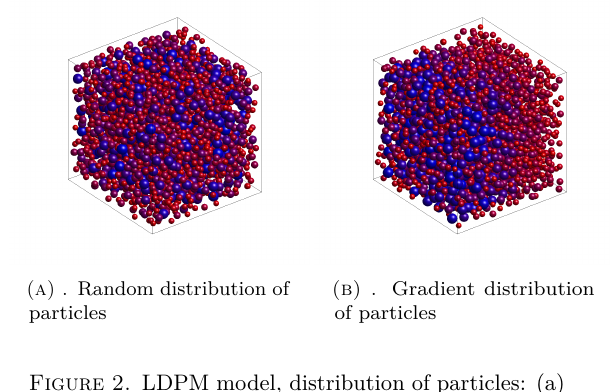
Figure 2. LDPM model, distribution of particles: (a) random distribution of particles; (b) gradient distri- bution of particles.